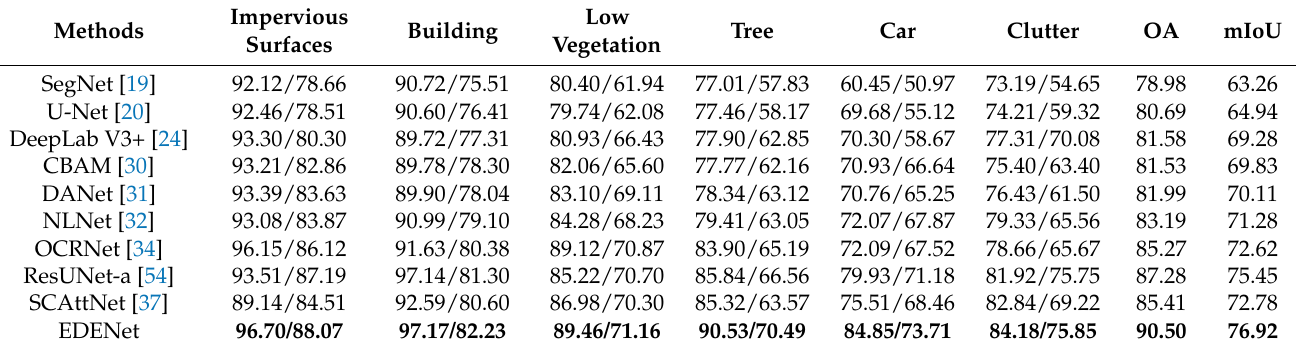
Table 5. Results on Potsdam dataset. Accuracy of each category is presented in the OA/IoU